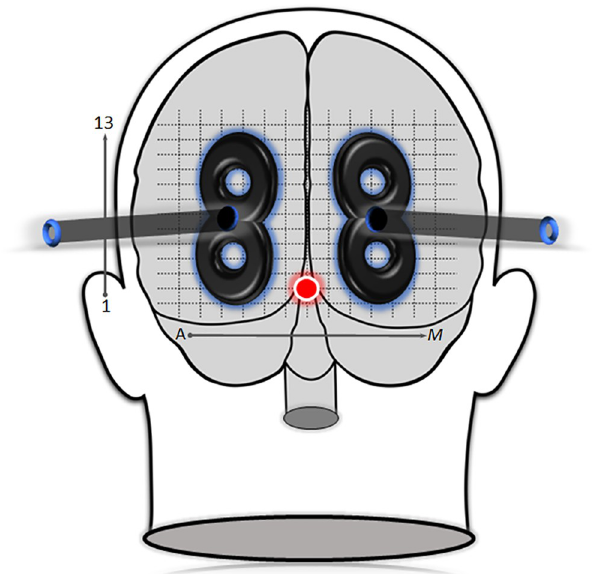
Fig 2. TMS mapping. Surface grid placement used to determine the phosphene hotspot. The x-axis is organized alphabetically (A-M), while the y-axis is arranged numerically (1–13). The red circle reflects the location of the inion at coordinate G-2 with two adjacent 40mm figure-of-eight coils placed over the occipital hemispheres.